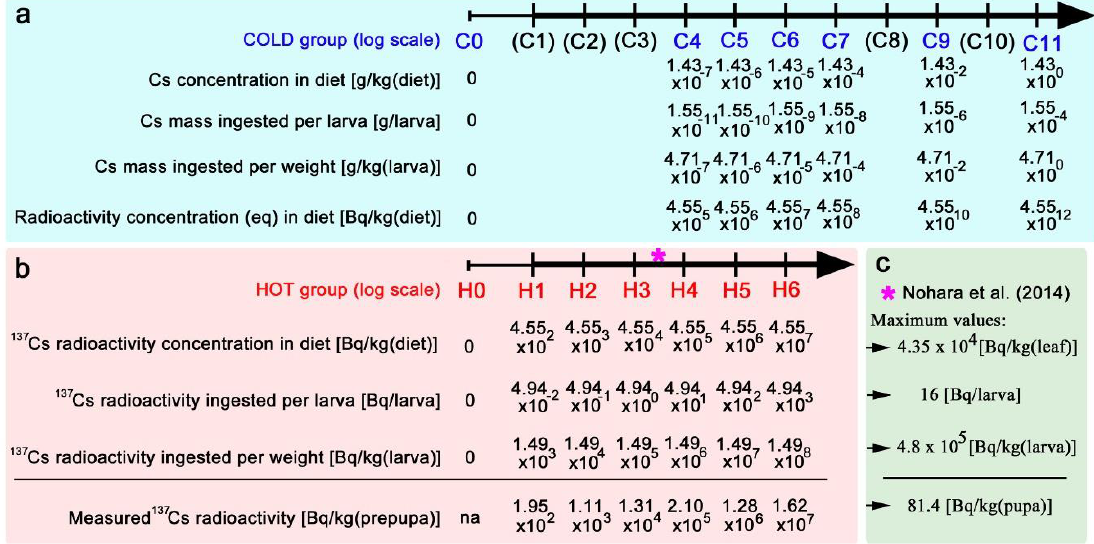
Figure 2. Caesium levels used in the present study. In a and b, numerical values were obtained from calculations based on the starting concentrations except for the last line in b. The amount of the artificial diet consumed was assumed to be 108.6 mg (see Materials and Methods). Larval weight was assumed to be similar to the weight and to be 0.033 g, from Nohara et al. [33]. ( a ) Nonradioactive (cold) caesium group. The radioactivity concentration equivalence was calculated based on the fact that 100 Bq of 137 Cs is 31.2 pg, according to Shozugawa [45]. C1, C2, C3, C8, and C10 were not used in the present study. ( b ) Radioactive (hot) caesium group. H4, H5, and H6 correspond to C4, C5, and C6, respectively. An asterisk indicates the levels of the previous internal exposure experiments. The bottom lines are not calculated but are measured values. na: Not applicable. ( c ) Radioactivity concentrations from the previous internal exposure experiments. Data were obtained from Nohara et al. [33]. The bottom concentration is not calculated but is the measured value.